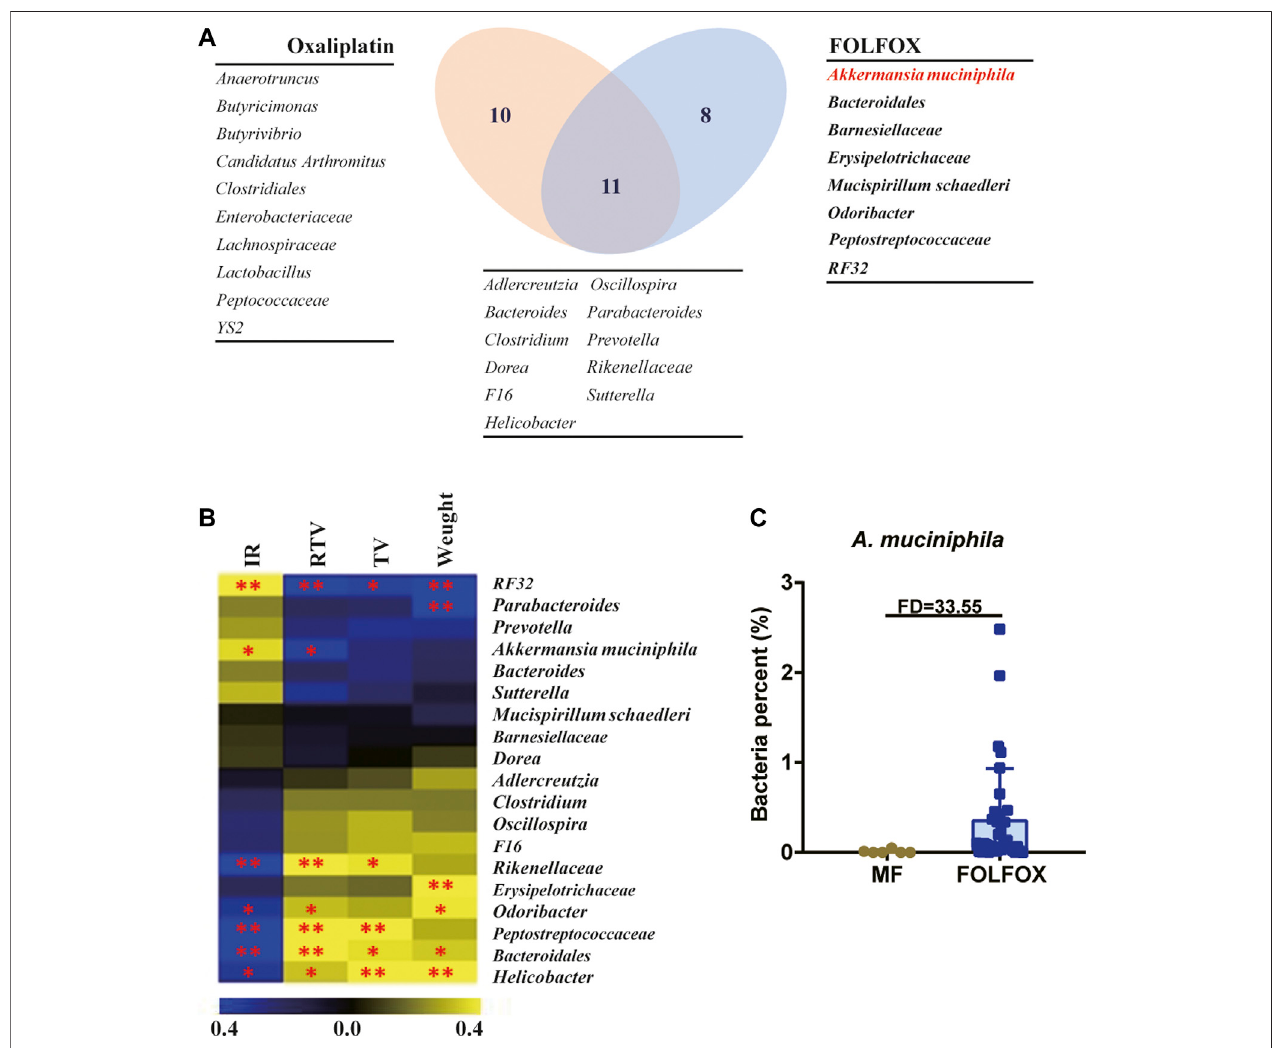
FIGURE 3 | A. muciniphila might be the key bacteria accounting for the superior ef fi cacy of FOLFOX. (A) Venn diagram illustrating the shared/unique differential gut microbiota OTUs after oxaliplatin and FOLFOX treatment. (B) Heatmap of Spearman correlation coef fi cient between pharmacodynamic indices after FOLFOX treatment and abundance of changed bacterial genera. The intensity of the colors represents the degree of association between the level of pharmacodynamic indices and abundance of changed bacterial genera determined by Spearman ’ s correlations. IR, Inhibition rate by Relative Tumor Volume. (C) Relative abundance of A. muciniphila in the MF and FOLFOX groups. The p -values < 0.05 were considered statistically signi fi cant, * p < 0.05, ** p < 0.01.